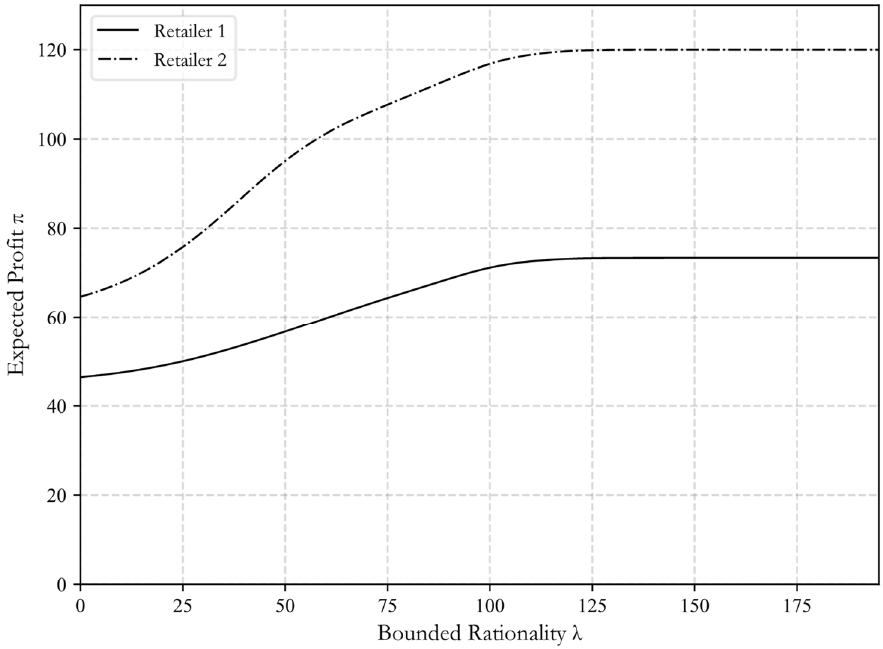
Figure 6. Retailers’ expected profit and bounded rationality.